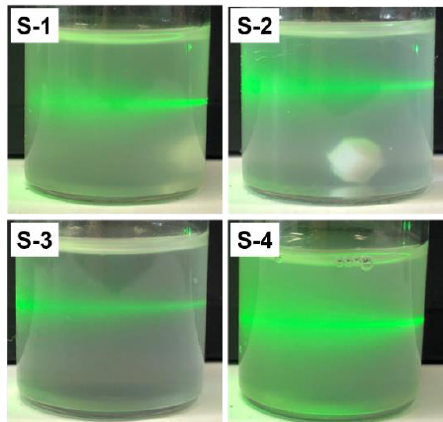
Figure 5. Photographs of i PP/ a PS miktoarm star polymer solutions irradiated by a laser beam after three days.